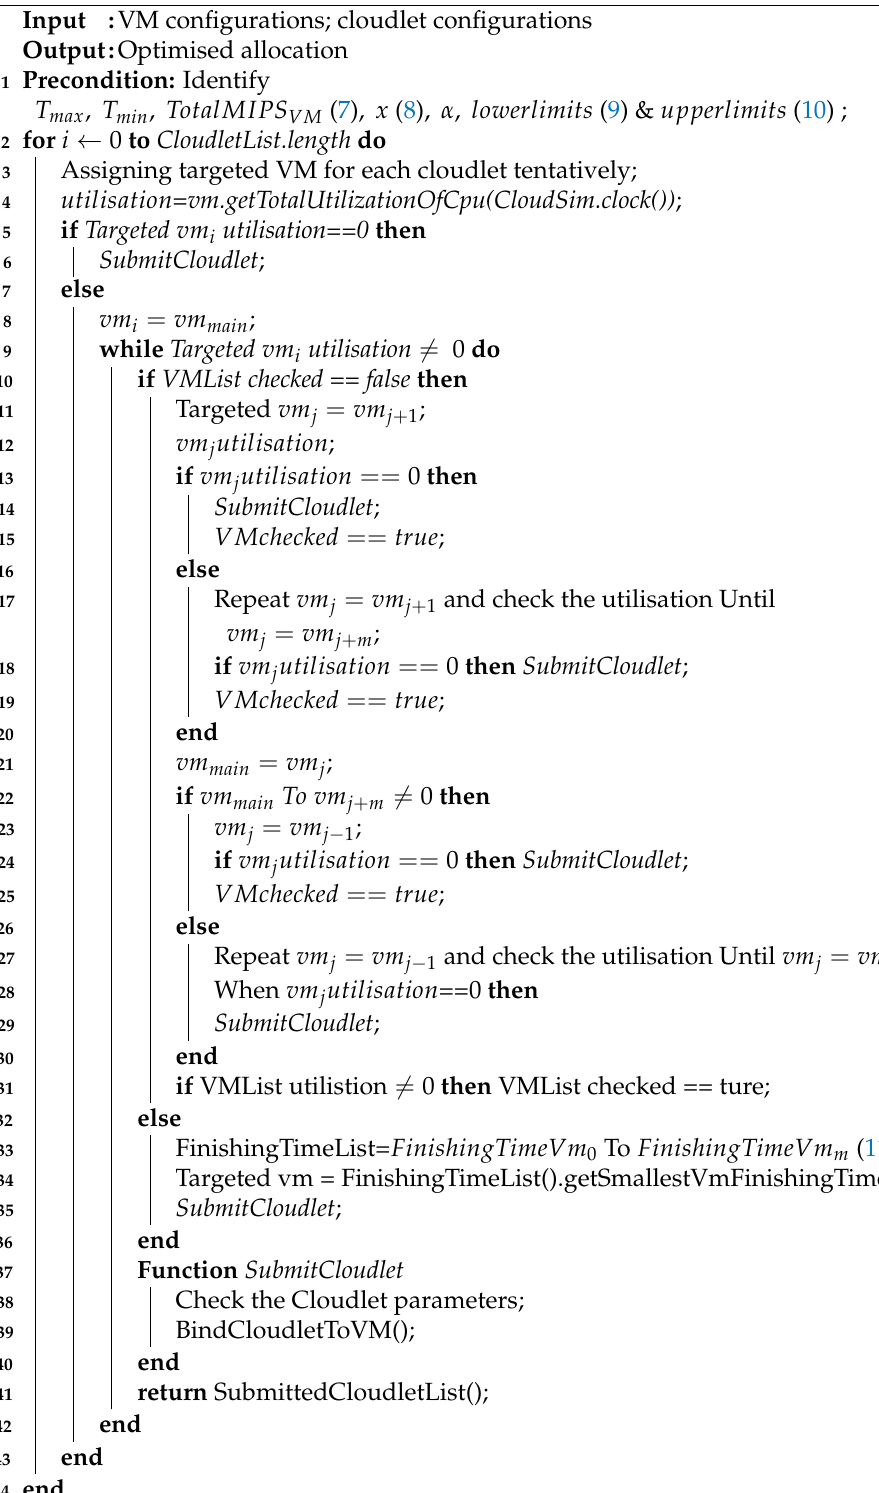
Algorithm 1: Locust scheduling